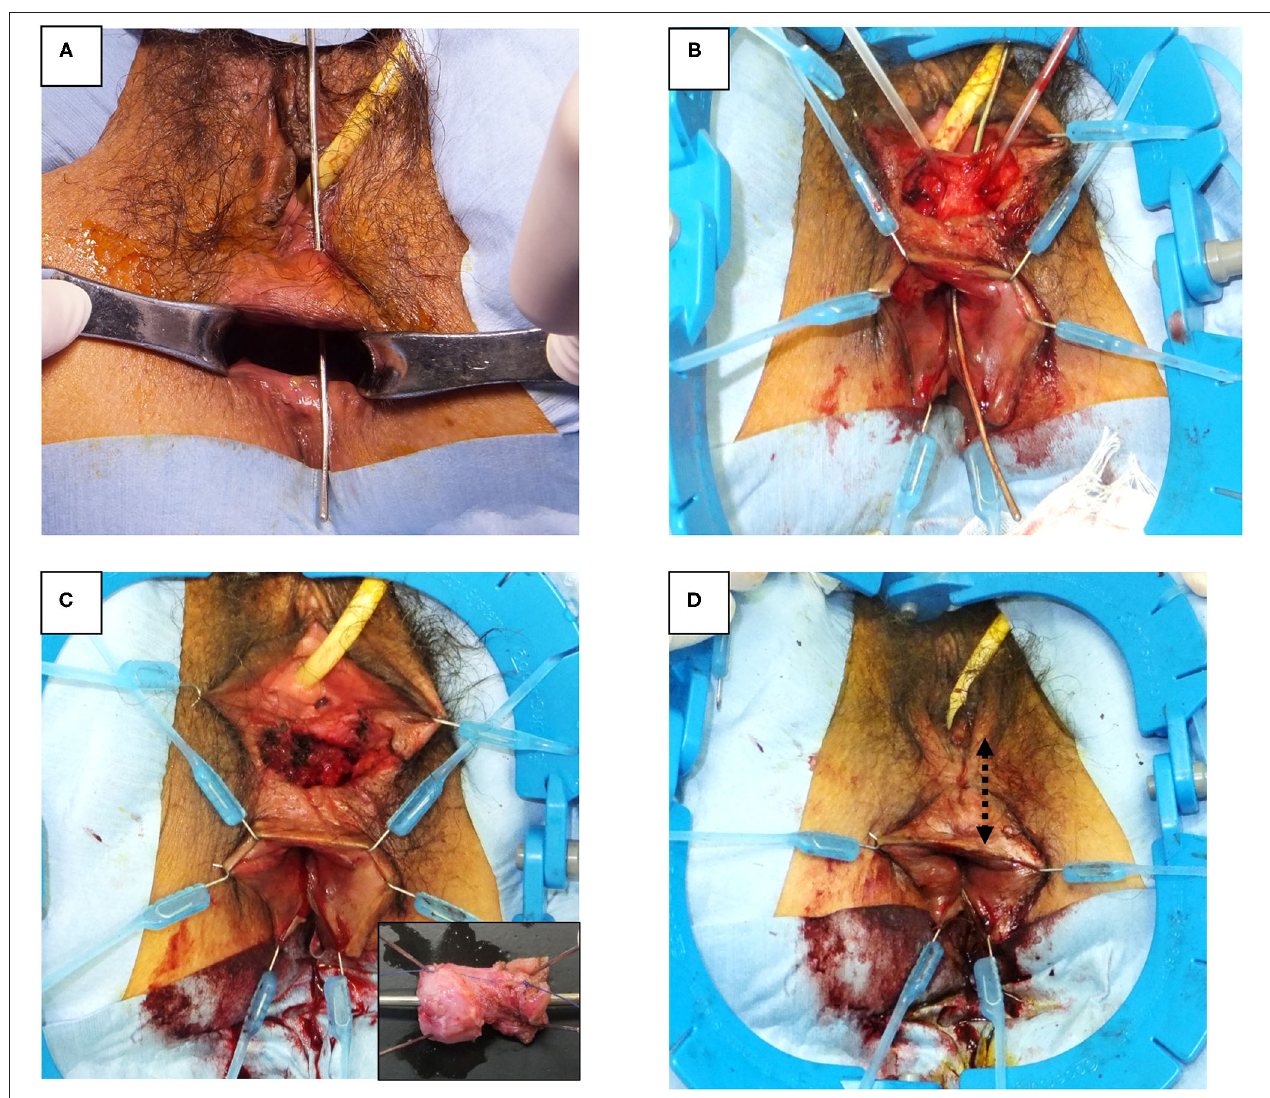
FIGURE 3 | Surgical procedure of rectoperineal fistula repair. (A) Identification of rectoperineal fistula with a probe through the fistula tract. (B) Transverse perineal incision and dissection of rectovaginal septum exposing fistula tract. (C) Fistula tract is completely excised from the rectovaginal septum. Small box, macroscopic feature of fistula tract (2 × 1cm). (D) Layered closure of rectum, perineal body, vagina, and skin are performed, respectively. The skin was closed along vertical direction (dotted